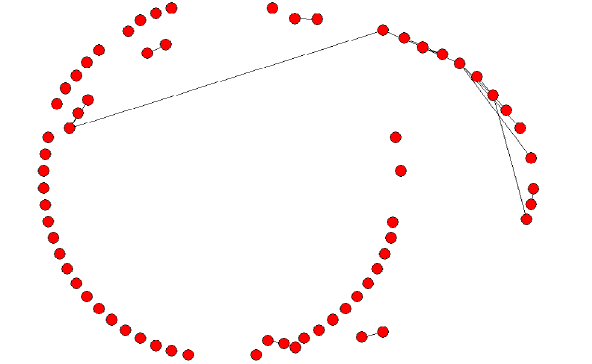
Figure 3: Knowledge Network